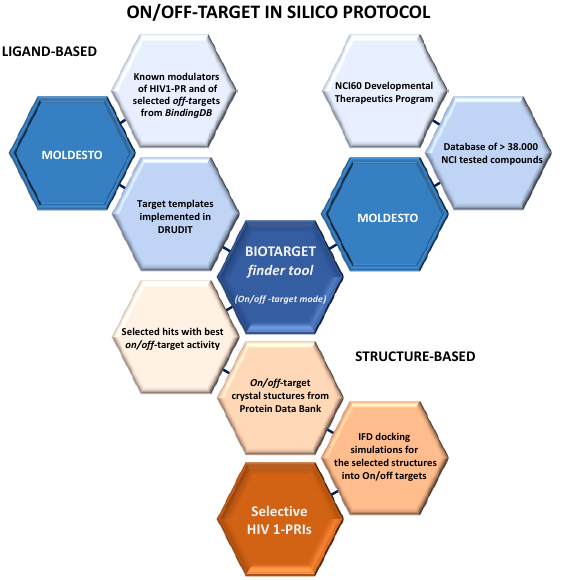
Figure 3. Workflow of the in silico mixed structure-ligand on/off-target approach proposed for the identification of new HIV-1 PR inhibitors.